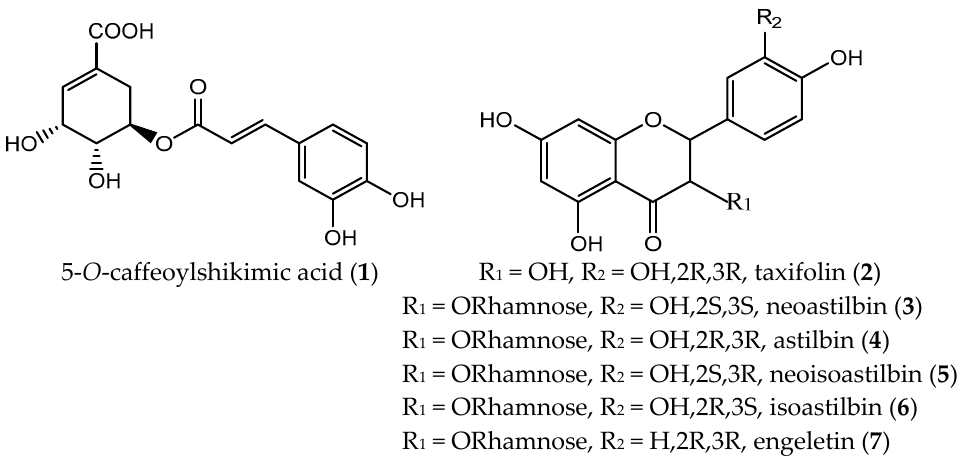
Figure 1. Structures of the compounds from the rhizome of S. glabra . (R: Rectus , right-handed; S: Sinister , left-handed).